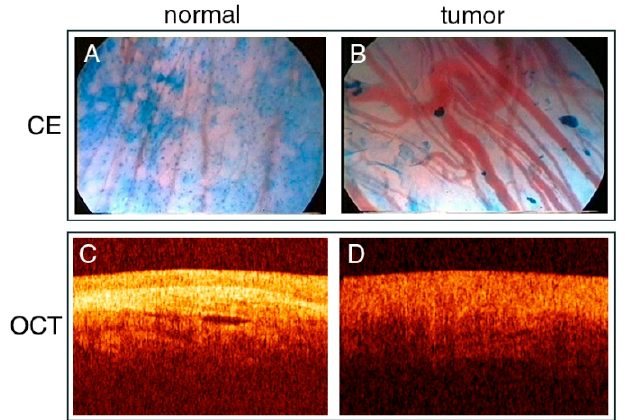
Figure 3. Clinical examples of contact endoscopy (CE) and optical coherence tomography (OCT) in laryngeal cancer. ( A ) Normal vascular network of the vocal fold in CE. ( B ) Vascular network of the vocal fold carcinoma in CE. ( C ) OCT image of healthy portion of larynx. ( D ) OCT image of exophytic tumor of larynx. A and B were adapted and reproduced from Stefanescu et al. (CC BY 4.0) [33]. C and D were adapted and reproduced from Sergeev et al. (CC BY 4.0) [52].